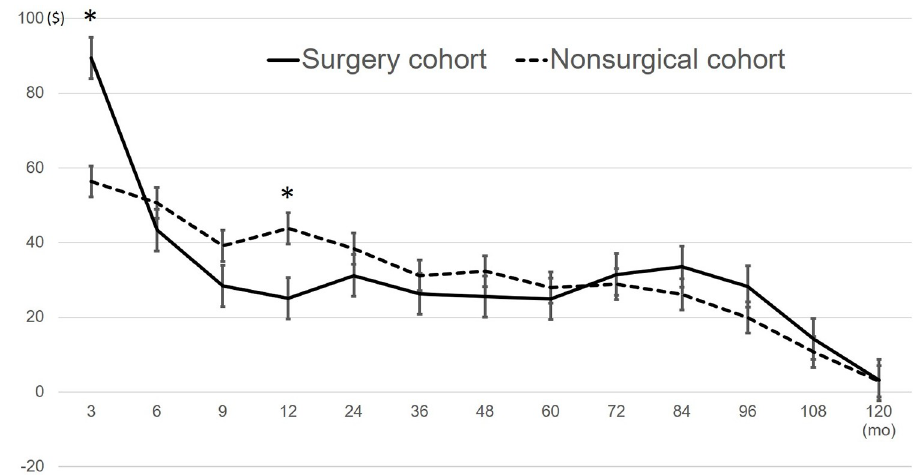
Fig 2. Monthly cost after treatment. The average monthly costs and standard errors are plotted in the graph. Asterisk ( � ) implies statistically significant difference between surgery cohort and nonsurgical cohort.